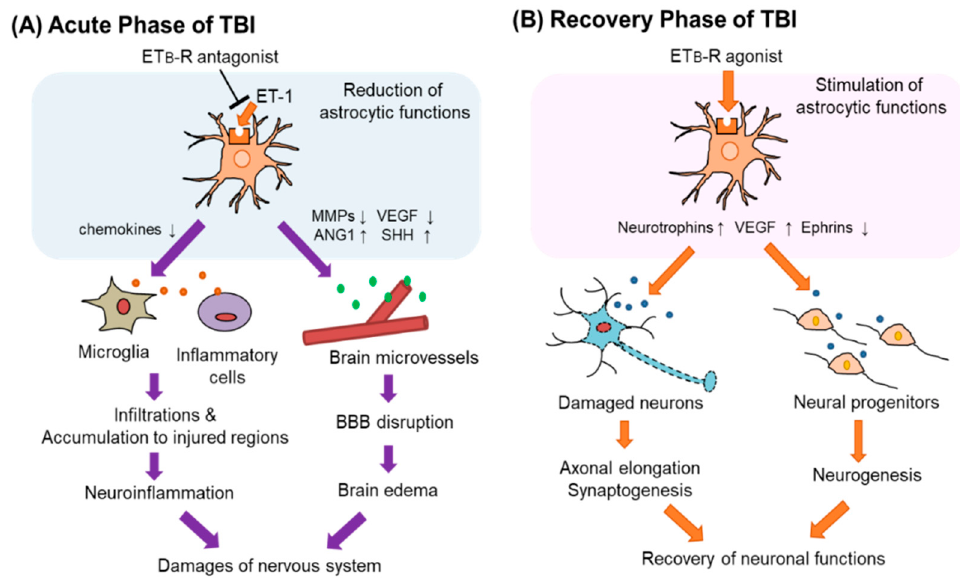
Figure 5. Astrocytic ET B -R as a therapeutic target of TBI. Astrocytic ET B -R may have different significance as a therapeutic target for patients with TBI in the acute and recovery phases. ( A ) In acute TBI, increased ET-1 increases the expression of MMPs and VEGF-A through the astrocytic ET B -R. It reduces angiopoietin-1 (ANG-1) and sonic hedgehog (SHH) production. Altered production of these vascular permeability regulators causes BBB disruption that induces brain edema. Stimulation of ET B -Rs also attracts inflammatory cells to the site of injury through increased production of chemokines. Administration of ET B -R antagonists in the acute phase of TBI reduces these astrocytic functions and may protect the nervous system. ( B ) In the recovery phase of TBI, the administration of ET B -R agonists is expected to be effective in recovering neuronal function impaired by TBI. Stimulation of astrocytic ET B -Rs promotes the production of neurotrophic factors, which promotes synaptogenesis and neurogenesis. ET B -R agonists also reduce the expression of ephrins. Then, regeneration of the damaged nervous system is promoted.